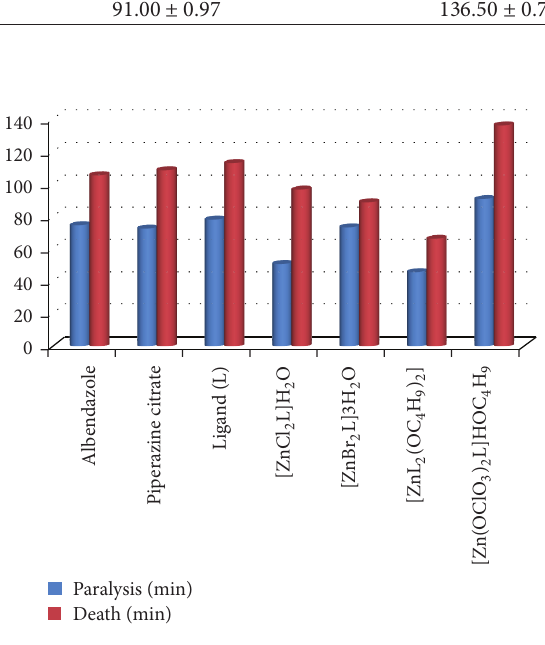
F 3: Anthelmintic